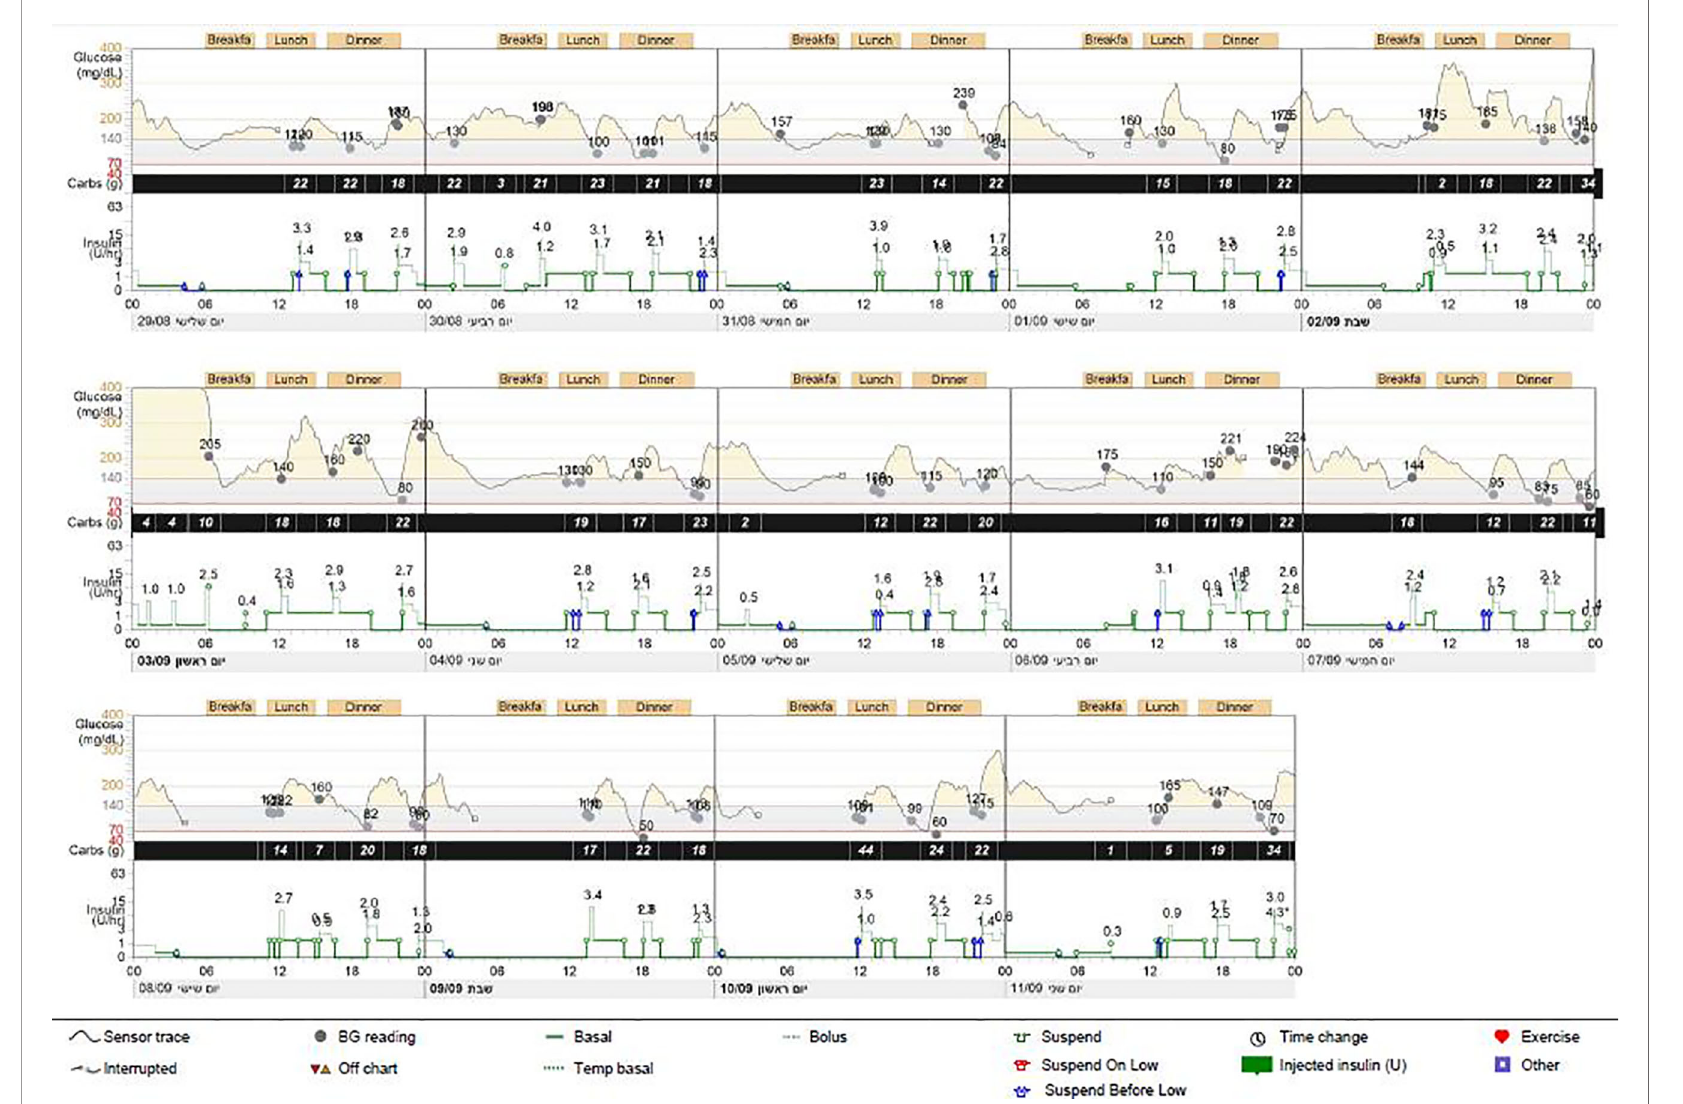
FIGURE 1 | Pump report for case 1. Report from continuous glucose monitoring and from continuous subcutaneous insulin infusion (CSII) (MiniMed 640G) demonstrating several pump-disconnection